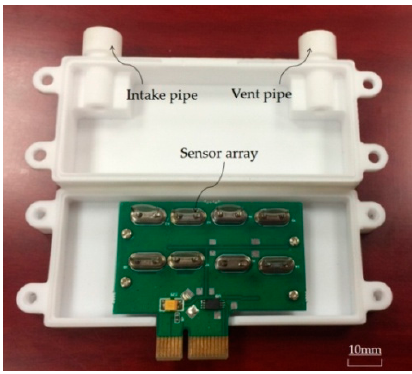
Figure 6. Photo of the sensor box.